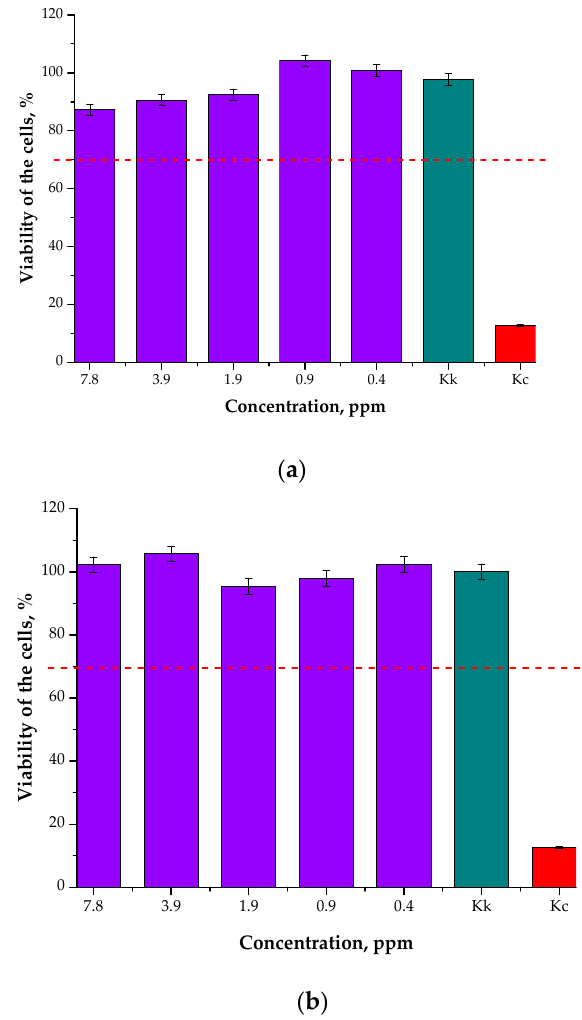
Figure 15. Results of the MTT reduction assay performed for the particle suspensions obtained in the water reaction medium ( a ) and the oil/water reaction medium ( b ).